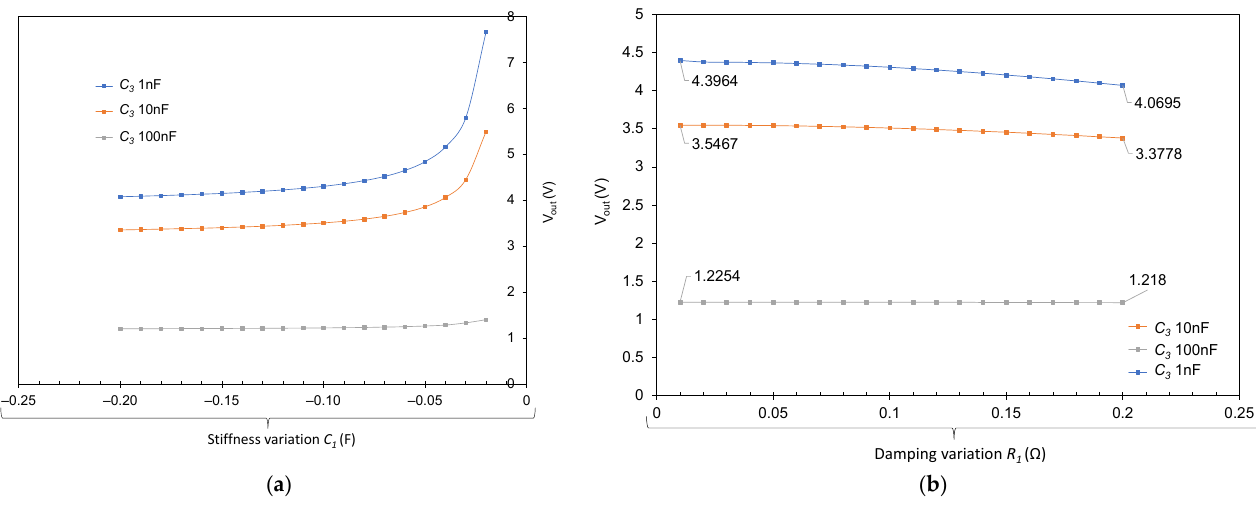
Figure 9. Output RMS voltage obtained in a capacitive load situation and high coupled system: ( a ) for stiffness variations, ( b ) for damping variations.